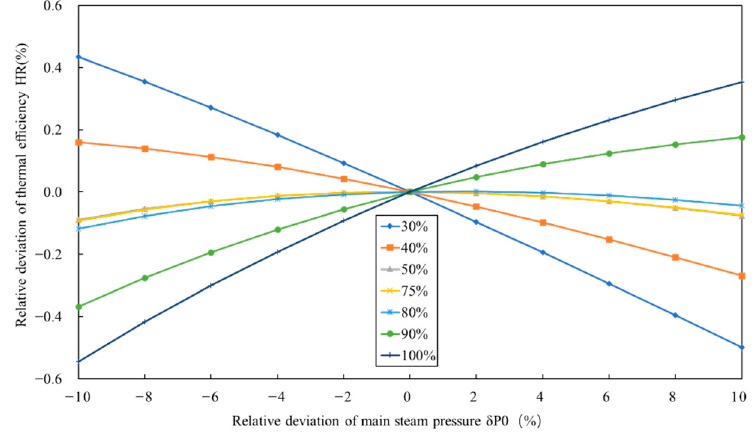
Figure 3. Variation in the relative deviation of thermal efficiency with main steam pressure disturb- ance under different output power loads.